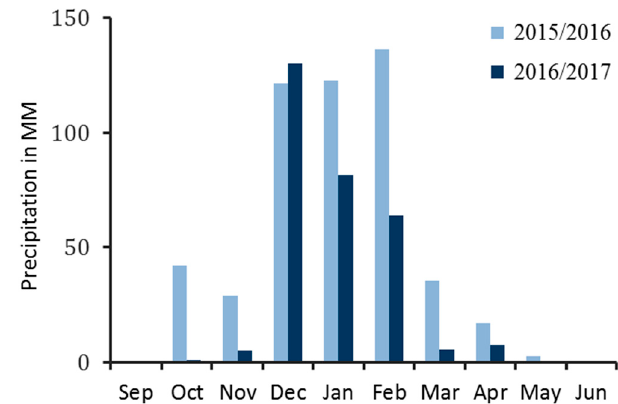
Figure 13. Intra-annual differences in precipitation between the near-surface observation period (2015/2016) and the UAV observation period (2016/2017). The precipitation amount was measured at the Tzur Hadassah station of the Israel meteorological service, about 4.5 km east of the Mata (M) site (Figure 1).